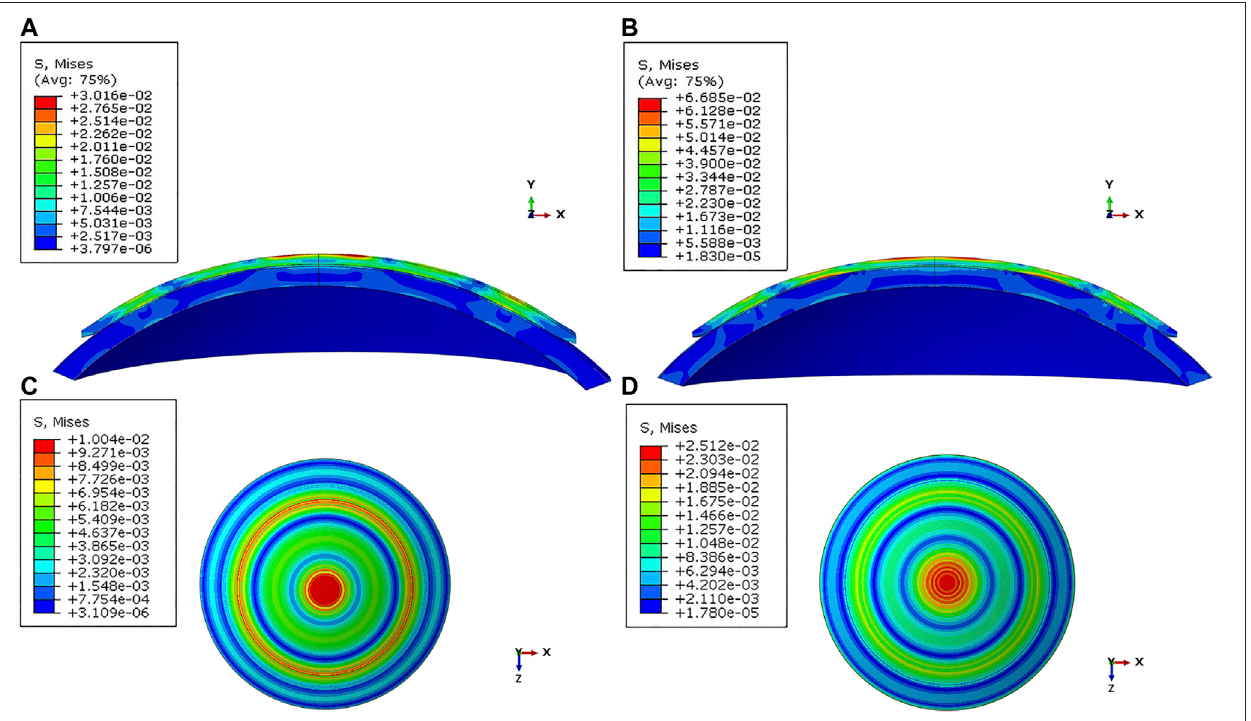
FIGURE3 | Distribution ofthe von Mises stressin the cornea under varied conditions. (A) Sagittalface: − 2.00 D/40.25 D/500 μ m; (B) Sagittal face: − 5.00 D/44.25 D/575 μ m; (C) En face: − 2.00 D/40.25 D/500 μ m; (D) En face: − 5.00 D/44.25 D/575 μ m.